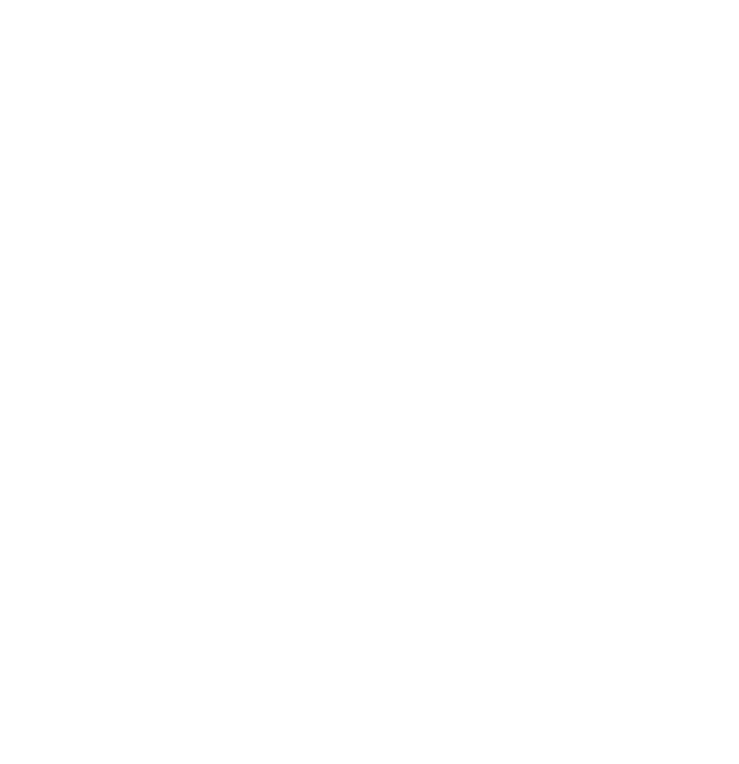
Figure 3. CT-Angio of 58 yo female with stage IIB acute right lower limb ischemia 14 days after SARS-CoV-2 infection.